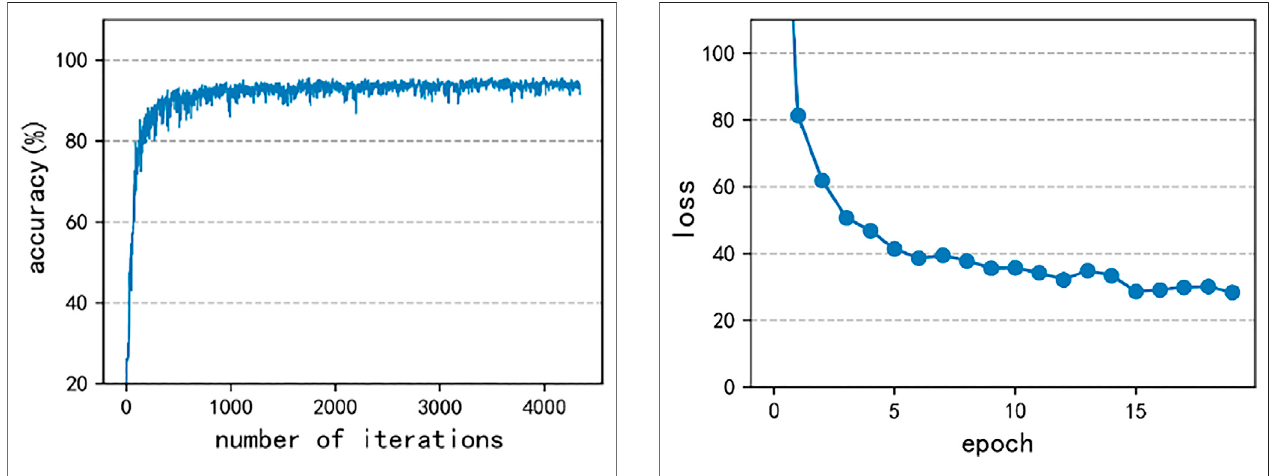
FIGURE 7 | Cure of test accuracy vs. iterations. FIGURE 8 | Curve of loss vs.